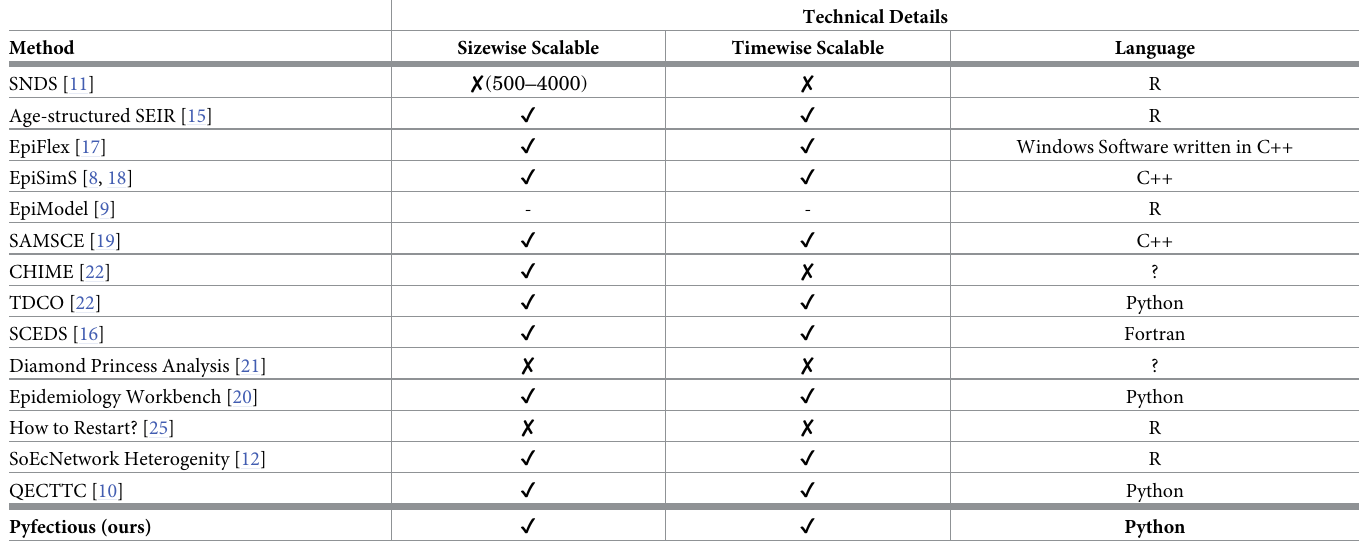
Table 4. A comparison of the simulators considering different technical